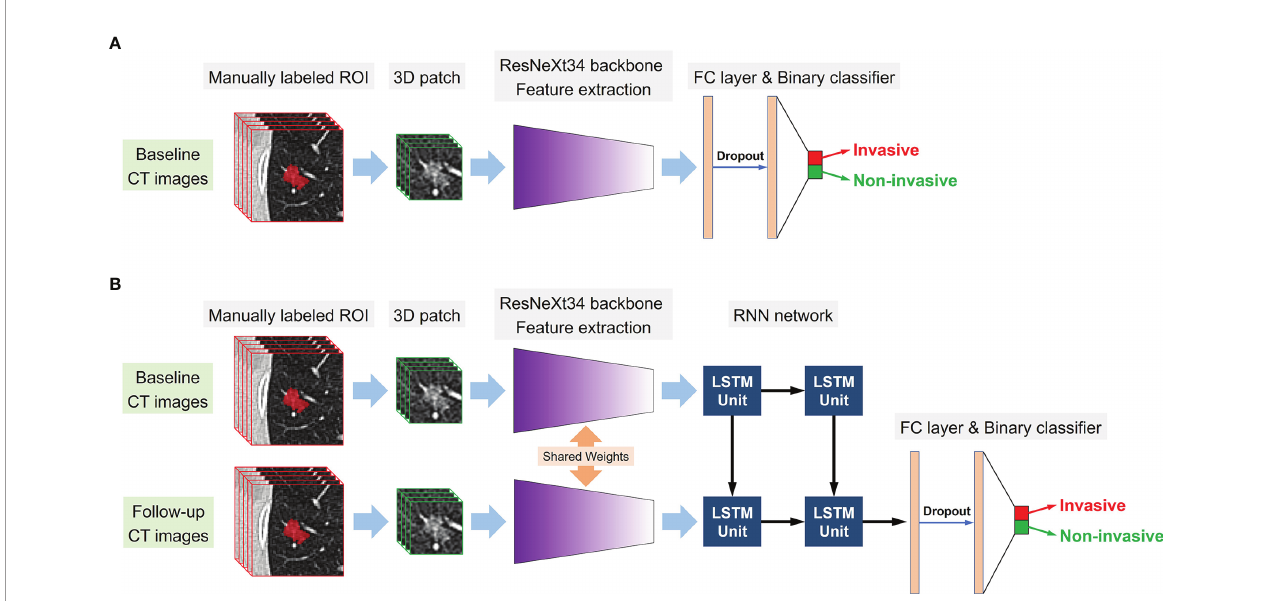
FIGURE 3 | Conceptual architecture of the single-DL model using only baseline CT images (A) and the serial-DL model integrating serial CT images at multiple timepoints (B)